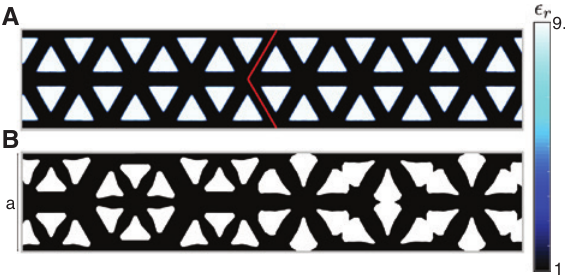
Figure 2: Initial PC and final PTI geometry. (A) The initial material configuration consists of a single photonic cell (PC) with triangular air holes (white) in Si (black) for which the two phases are identical. (B) The final photonic topological insulator (PTI) material configuration. Both the shape and topology of the second phase have changed from the initial guess, while only the shape has changed for the first phase. The interface between the two phases is highlighted in